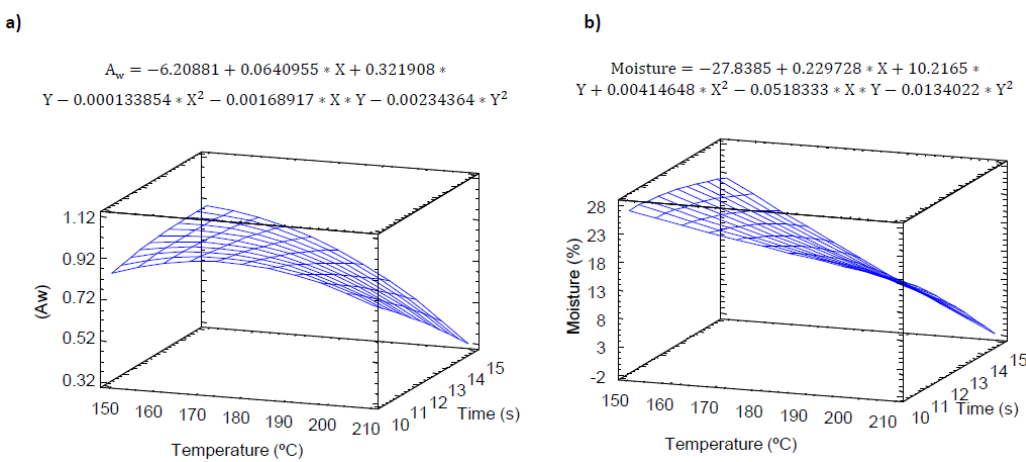
Figure 1. Response surface model of the e ff ect of temperature and time on ( a ) a w and ( b )